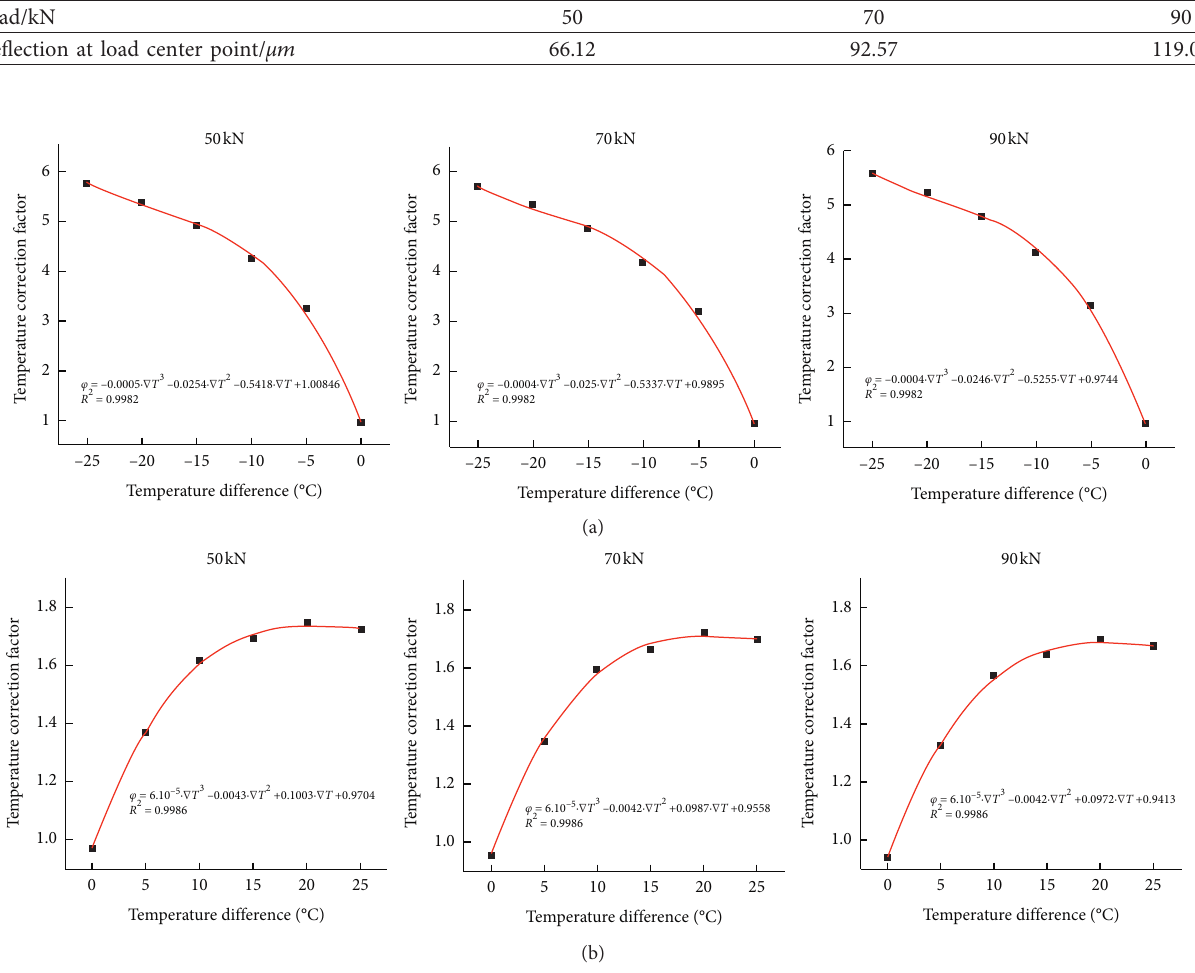
Table 5: Deflections at plate angle load center point under three-stage loads (without considering temperature effect). Load/kN